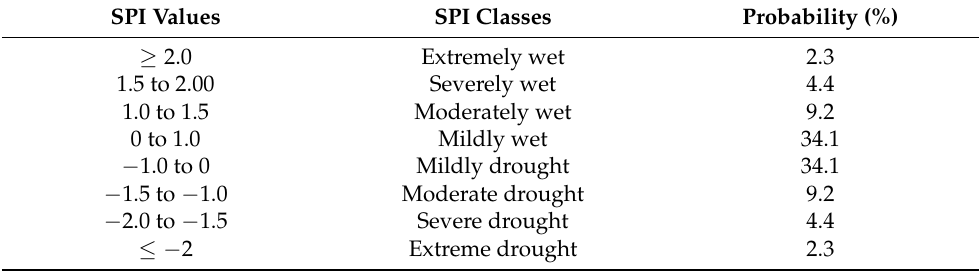
Table 1. Event classification based on SPI values and their probability of occurrence